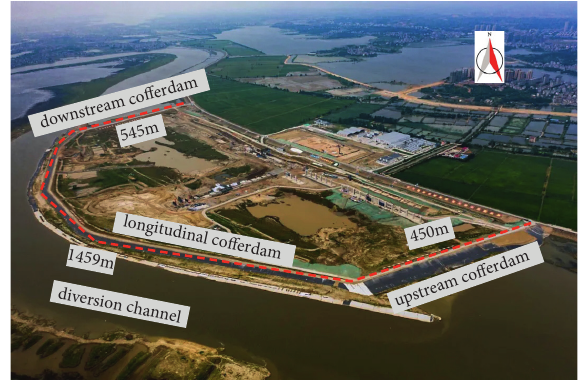
Figure 1: The project overview: layout of the cofferdam diversion